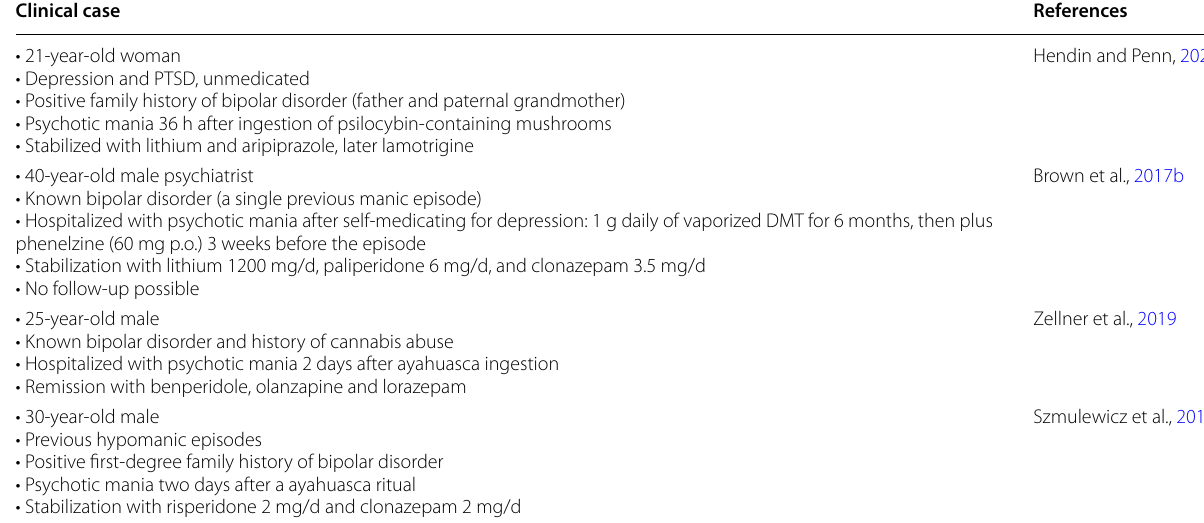
Table 1 Overview of case reports of psychedelics-induced mania Clinical